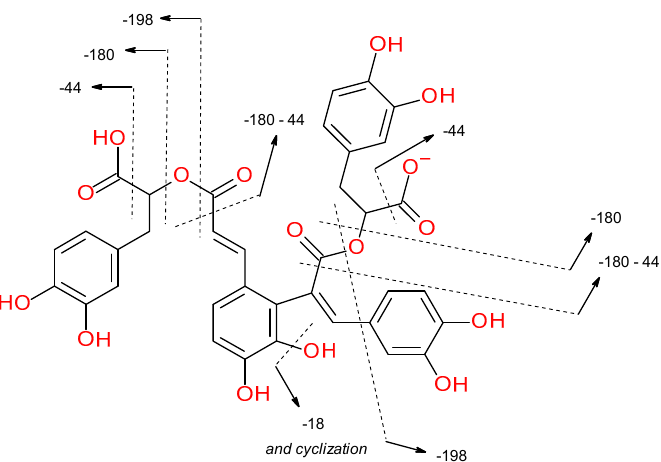
Figure 4. Proposed MS/MS fragmentation pathway of caffeetannins (e.g., salvianolic acid E (tetramer)). Quantification of principal polyphenols was carried out by the high performance liquid chromatography coupled with a diode-array detector (HPLC-DAD) method described previously by